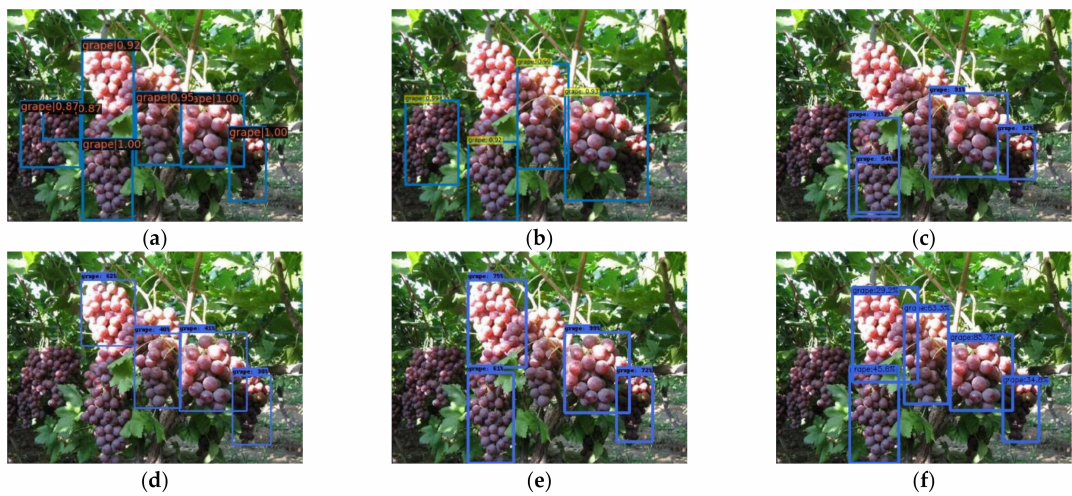
Figure 8. Bunches of grape detection: ( a ) SwinGD, ( b ) DETR, ( c ) YOLOv3-SPP, ( d ) Faster-RCNN, ( e ) SSD, ( f ) YOLOX.